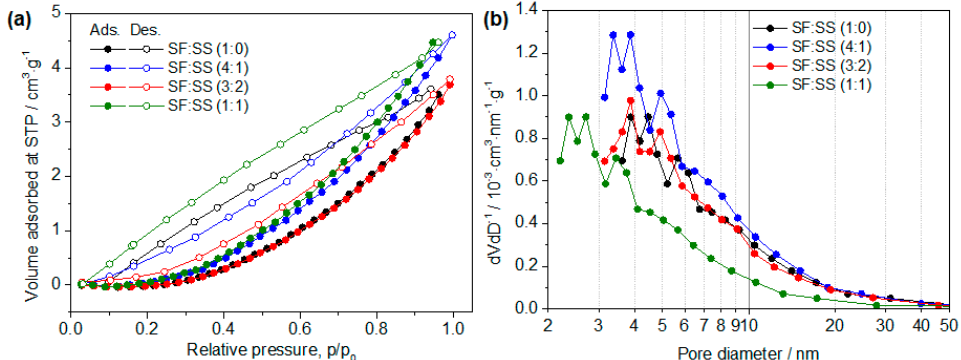
Table 1. Specific surface area and pore properties of SF and composite sorbent at different SF:SS compositions.